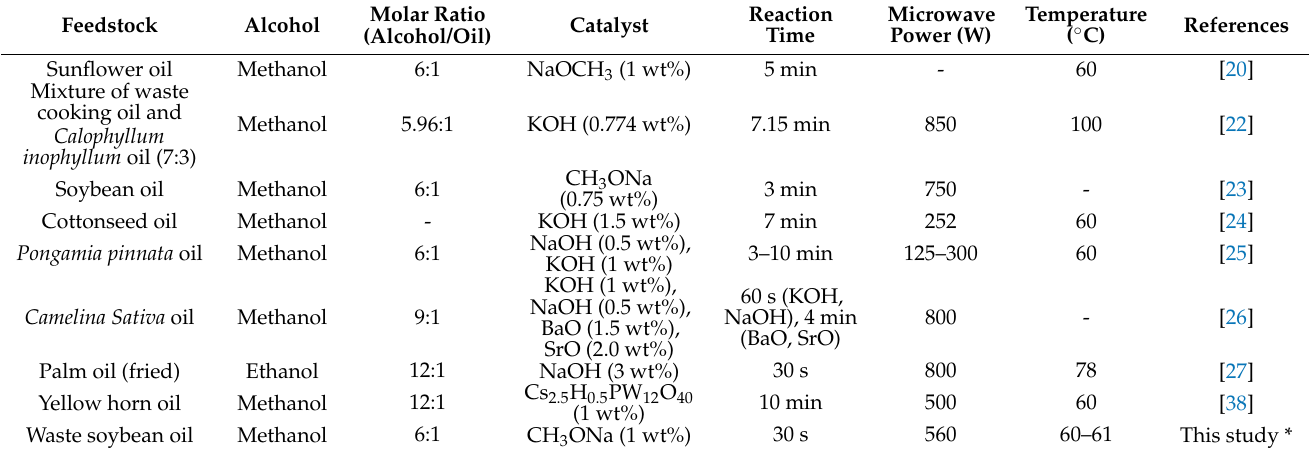
Table 1. Summary of experimental factors applied in a microwave-assisted transesterification